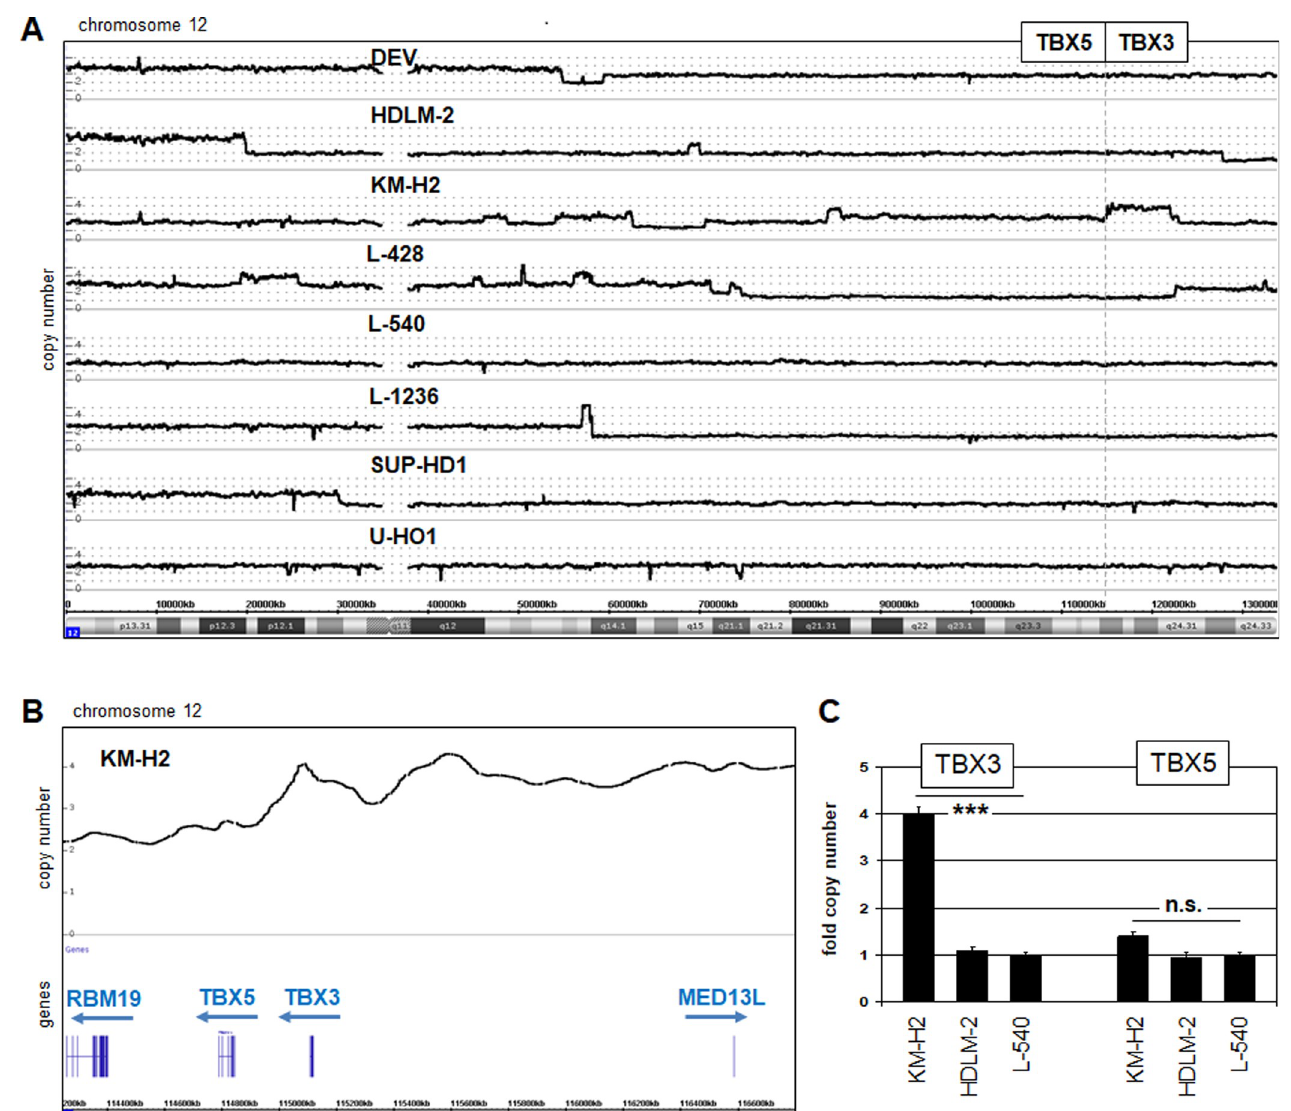
Fig 3. Genomic analyses of the TBX3 and TBX5 locus. (A) Genomic profiling data for chromosome 12 of eight HL cell lines. The neighboring gene loci of TBX3 and TBX5 are indicated, revealing amplification in KM-H2. (B) Enlarged picture of genomic profiling data for KM-H2, showing amplification of TBX3 but not of TBX5. Genomic Q-PCR analysis of HL cell line KM-H2 in comparison to HDLM-2 and L-540 confirmed amplification of the TBX3 gene in